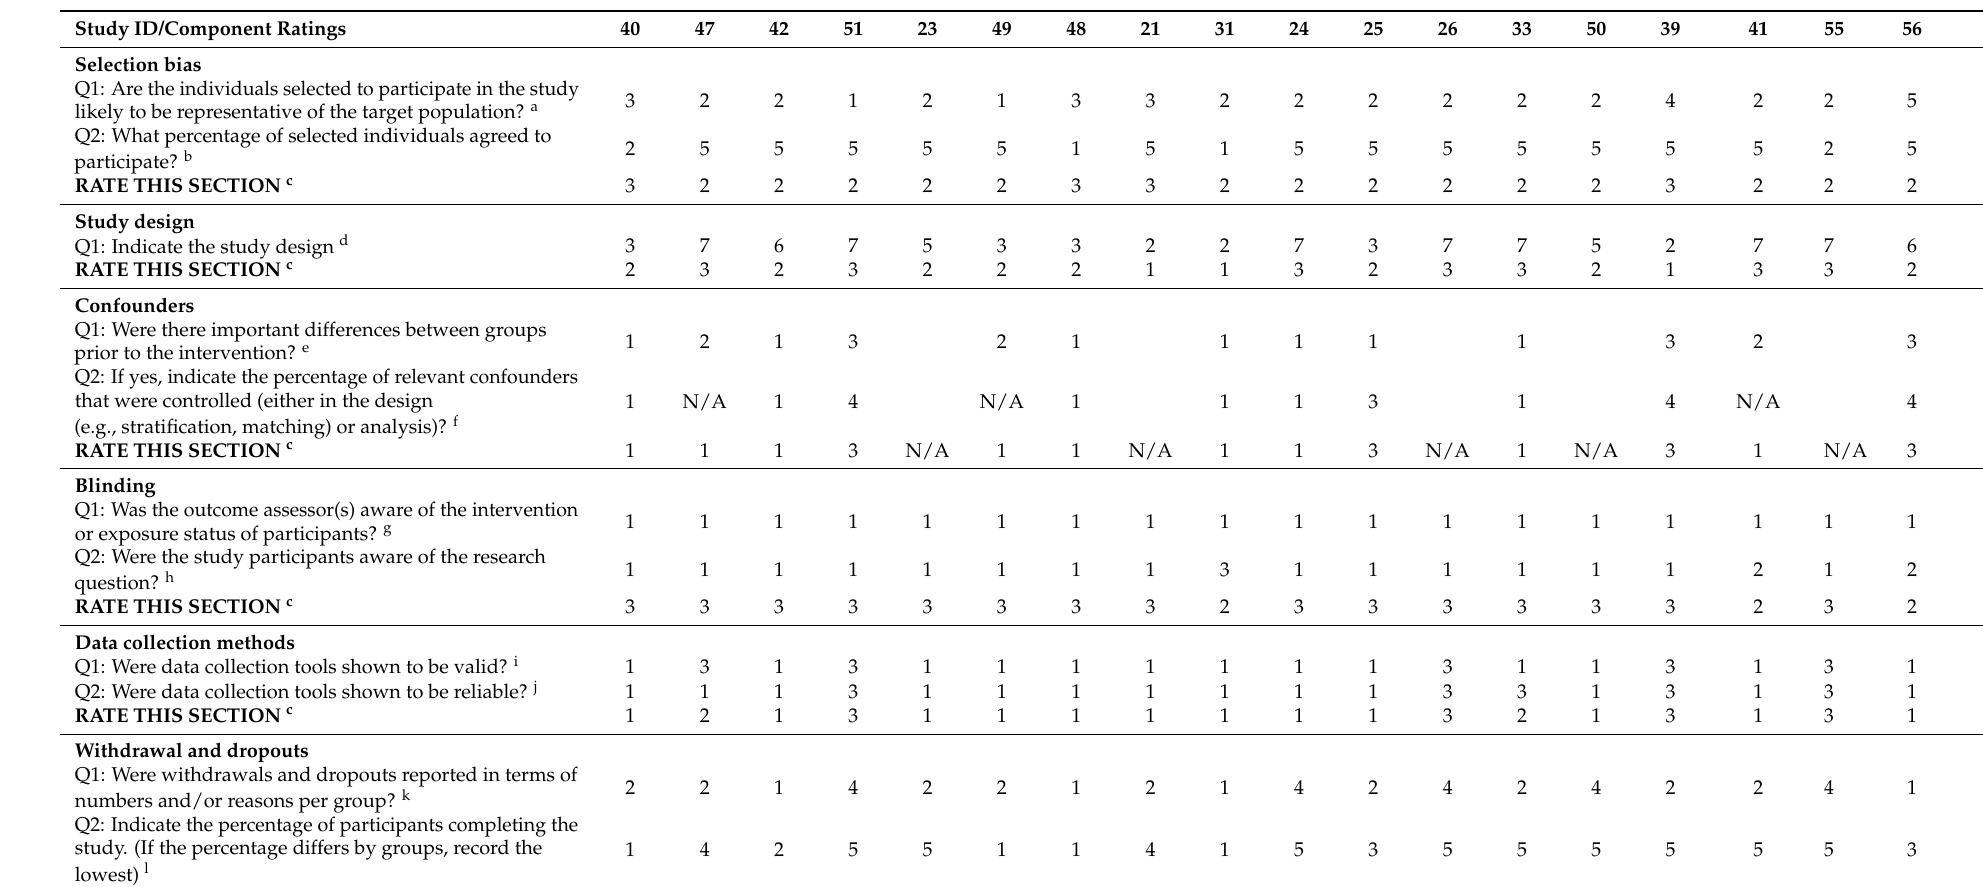
Table A1. Design quality analysis for the Pok é mon GO